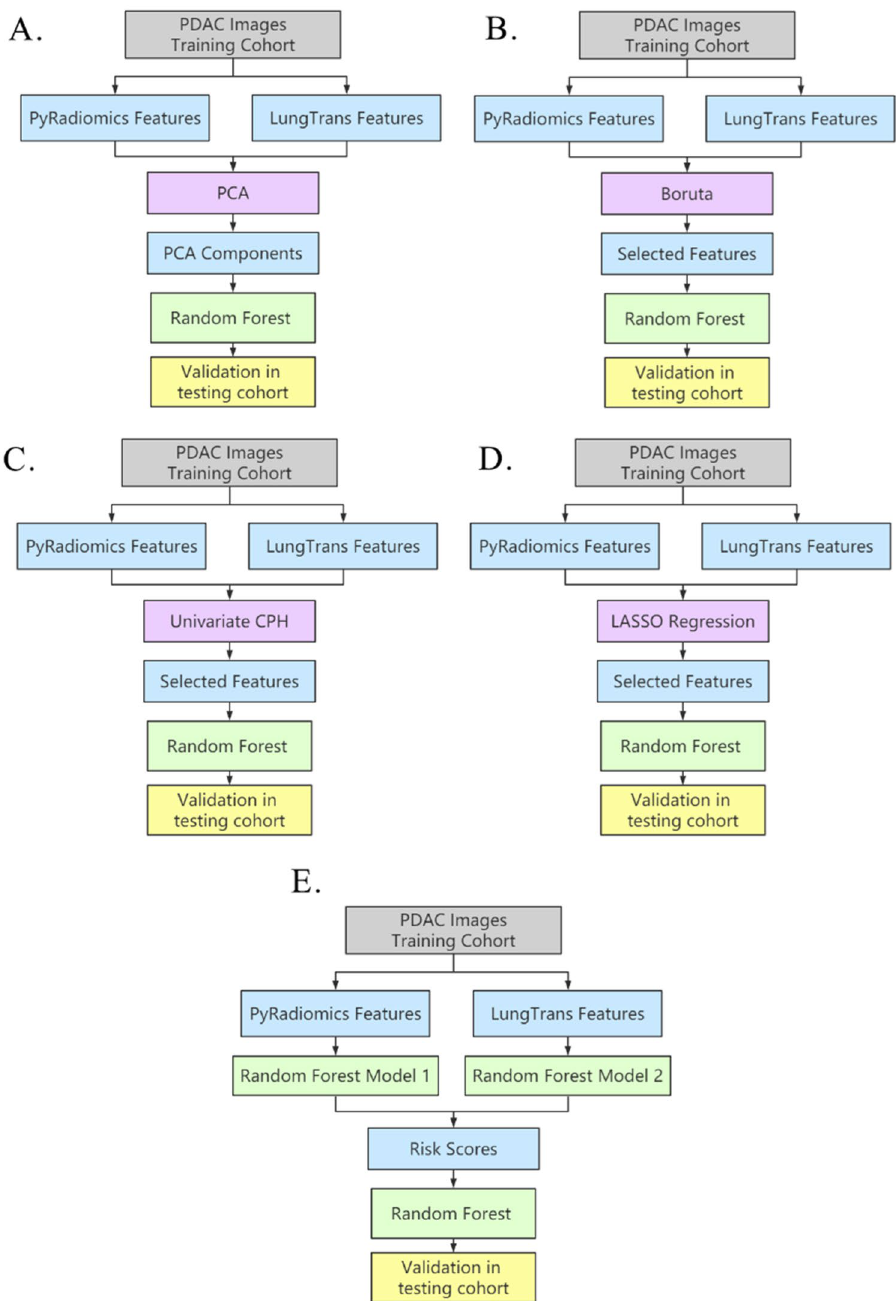
Figure 2. Pipelines for different feature reduction/fusion methods. ( A ) Unsupervised feature fusion using PCA. ( B ) Supervised feature reduction using Boruta. ( C ) Supervised feature reduction using Cox-Regression. ( D ) Supervised feature reduction using LASSO Regression. ( E ) The proposed risk-score based feature fusion